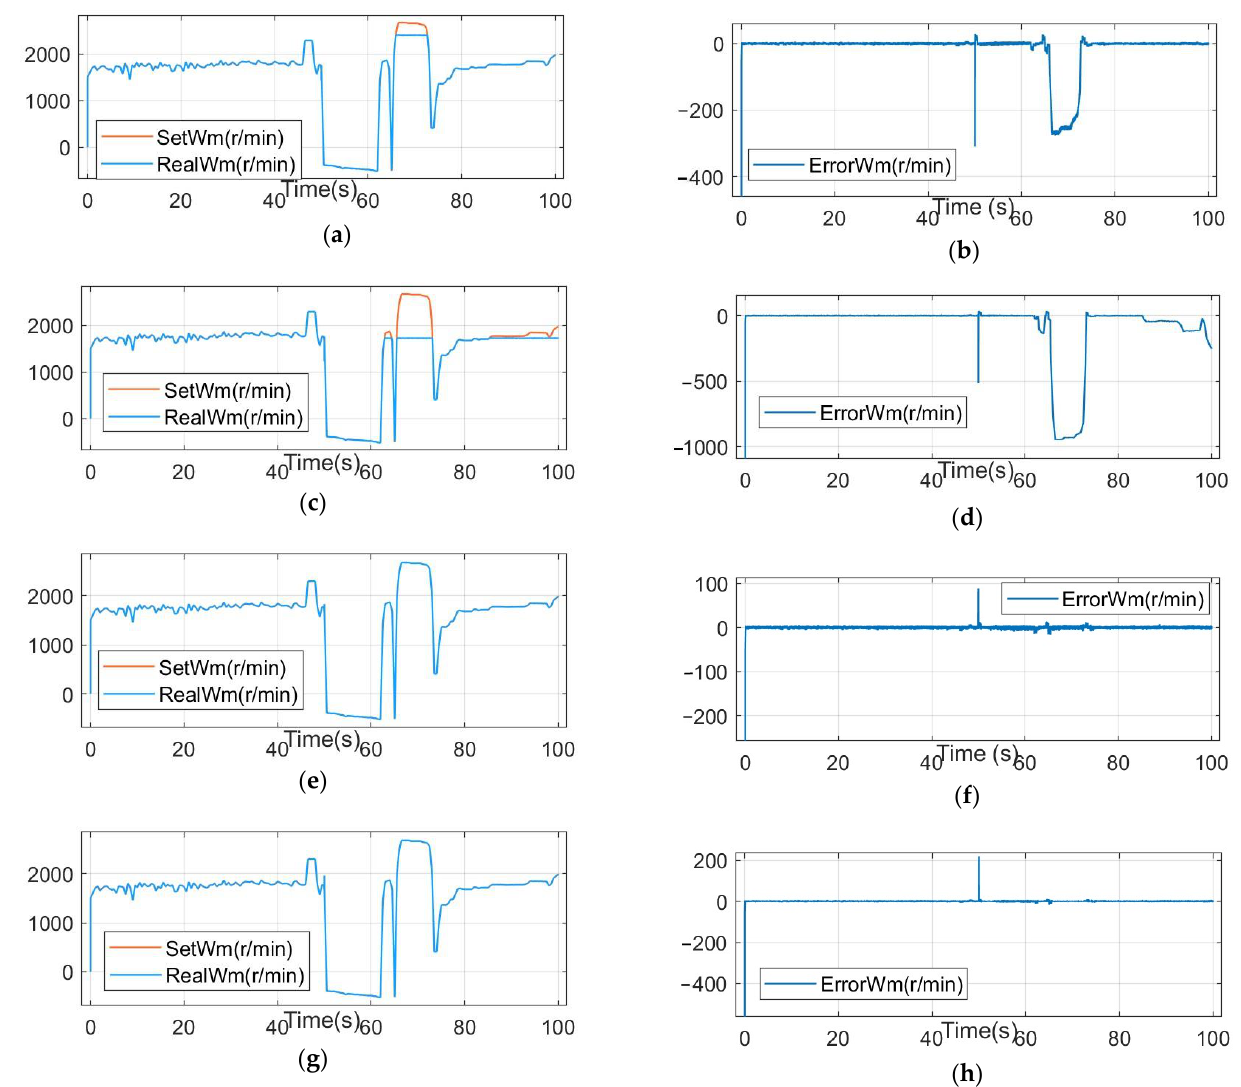
Figure 4. Speed control of the thruster in the fault states: ( a ) thruster speed control with an entanglement fault; ( b ) control error of a thruster with an entanglement fault; ( c ) thruster speed control with a jamming fault; ( d ) control error of a thruster with a jamming fault; ( e ) thruster speed control with a breaking fault; ( f ) control error of a thruster with a breaking fault; ( g ) thruster speed control with a falling-off fault; ( h ) control error of a thruster with a falling-off fault.